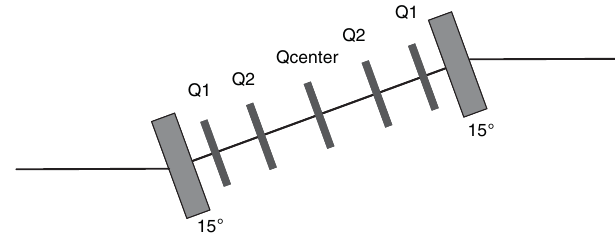
FIG. 3. Drawing of the translating dogleg where the bunch compression is done.